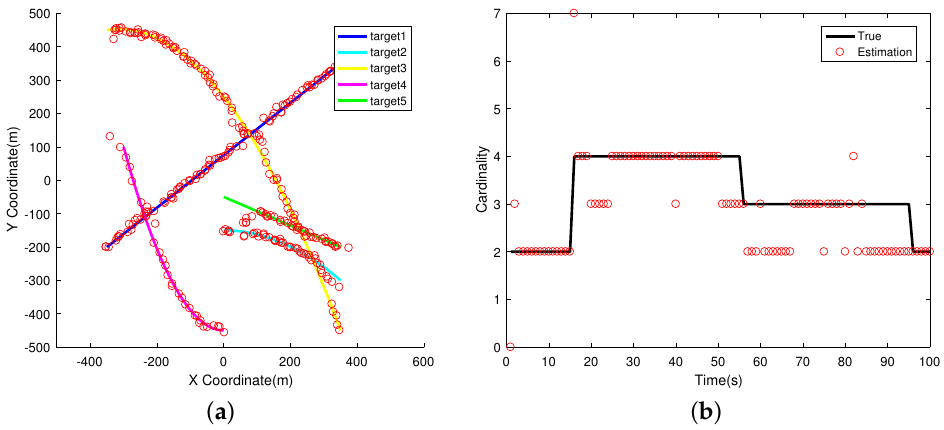
Figure 2. The position and cardinality estimation of GM-PHD. ( a ) Position Estimation; ( b ) Cardinal- ity